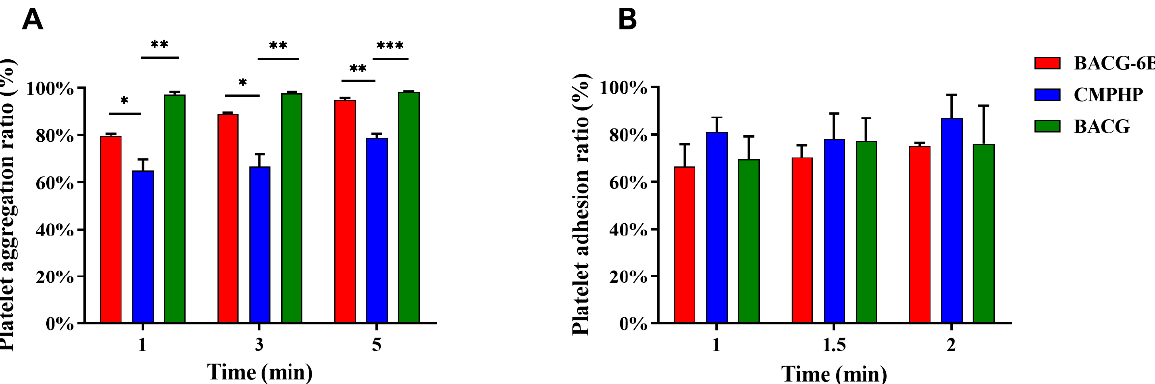
Figure 5. ( A ) Platelet aggregation test; ( B ) platelet perfusion adhesion test (mean ± SD, *** p < 0.001, ** p < 0.01, * p < 0.05, n = 3).